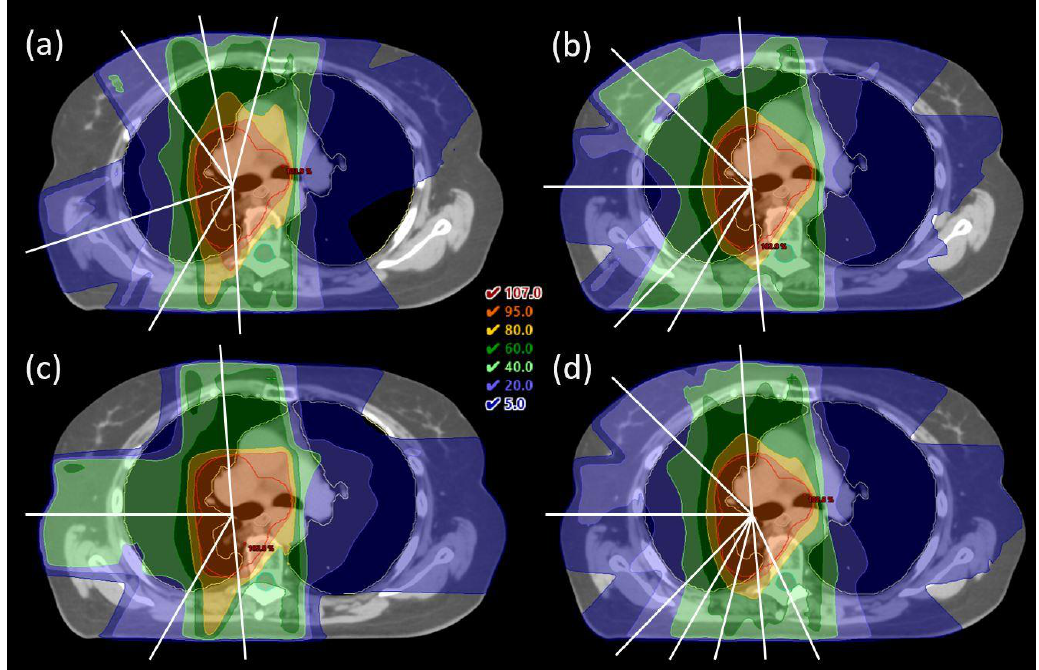
Figure A2. ( a ) CLIN plan with manually selected beam angles for patient 25, with a centrally located tumor. ( b – d ) iCE plans with 6, 4 and 8 optimized beam angles for the same patient. Dose is shown relative to the prescribed dose (66 Gy). Contours are the PTV (red), lungs (yellow), esophagus (grey) and spinal cord (cyan), and beam angles are indicated by white lines. For this patient, the distribution of high dose in the CLIN plan was not as conformal as desired. The 6-beam iCE plan has slightly higher lung and esophagus D mean and better high dose conformity.